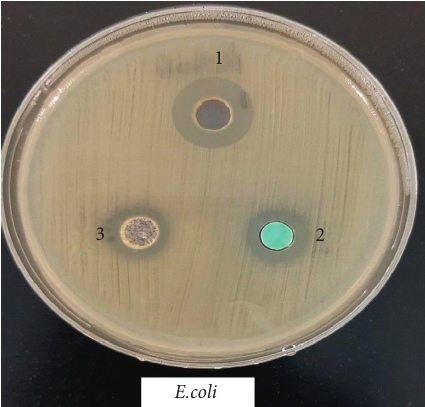
Figure 13: Microbiological screening of Ni(II), Cu(II) and Mn(II) complexes against E.coli.